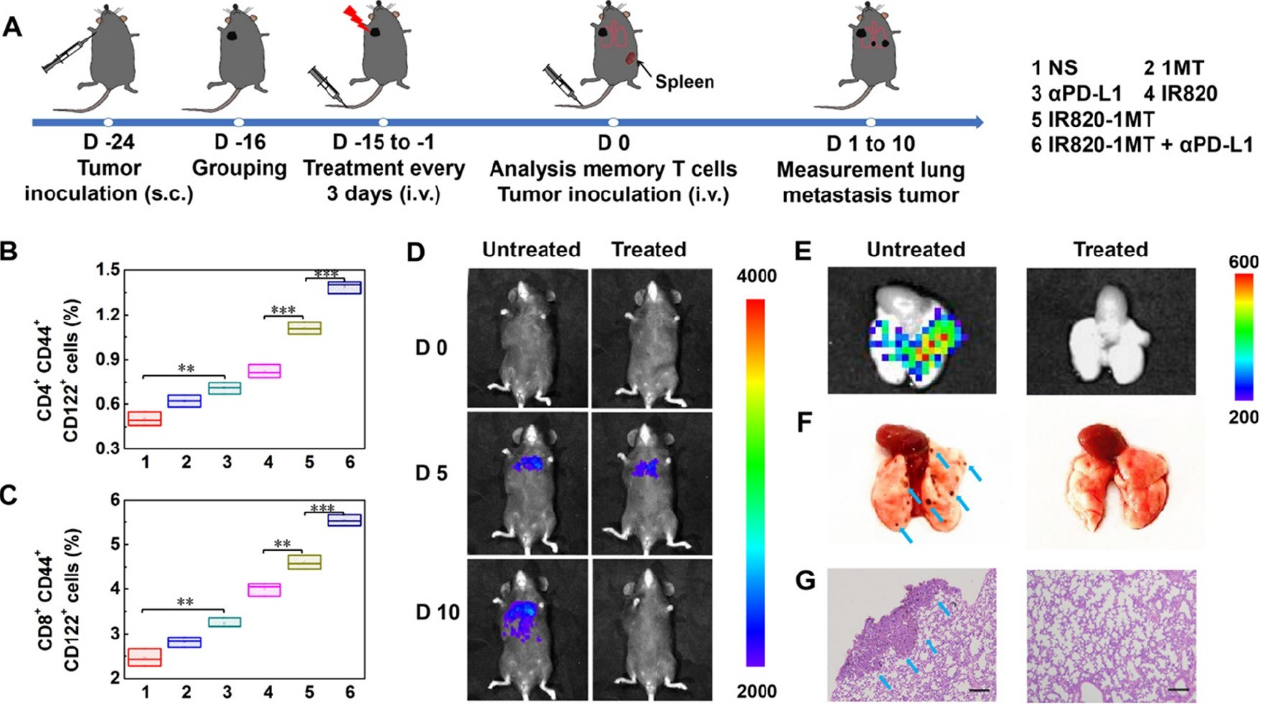
Figure 7. Ability of the immuno-PTT mediated by IR820-1MT conjugate nanoparticles in combination with PD-L1 blockade to prevent tumor recurrence in the lungs. ( A ) Schematic representation of the therapeutic approach; ( B , C ) Levels of T EM cells in the spleen after the different treatments; ( D ) Bioluminescence images of lung metastases in mice overtime; ( E ) Ex vivo bioluminescence and ( F ) optical images of the lungs; ( G ) HE staining of the lung slices. Reprinted with permission from [75]. Copyright 2019 American Chemical Society. NS: normal saline; α PD-L1: anti-PD-L1 Ab; IR820: IR820 + Laser irradiation; IR820-1MT: IR820-1MT conjugate nanoparticles + Laser irradiation. ** p <